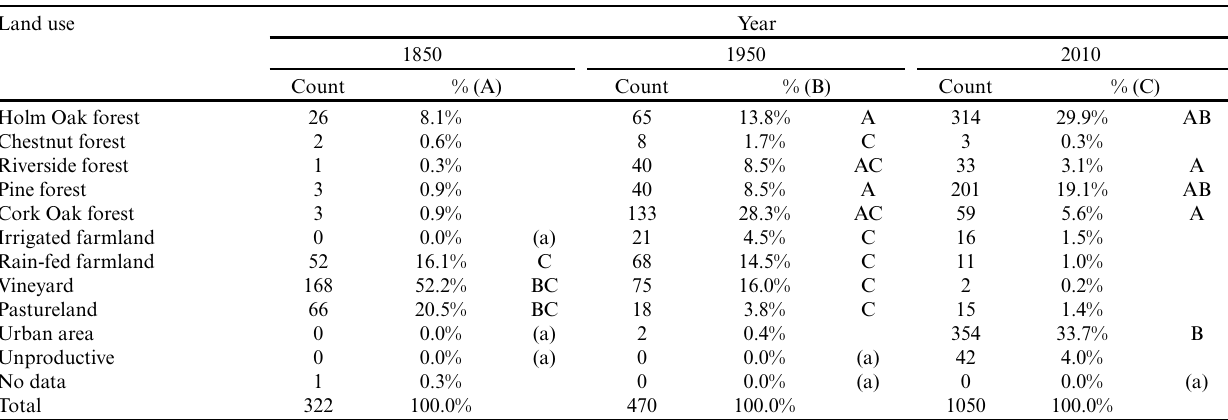
Table 5 . Plot count and percentage according to main land use for years 1850, 1950, and 2010. Land use